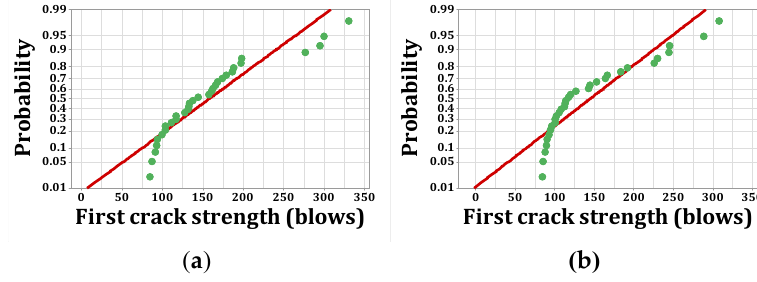
Figure 18. Distribution plots for first crack (dry): ( a ) F5, ( b ) F2F3.